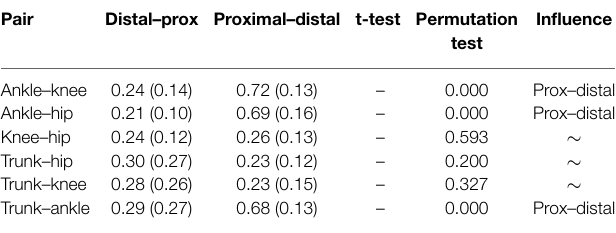
TABLE 1 | Average values (SD) computed from causal influence in the sagittal plane kinematic data during running. Pair Distal–prox Proximal–distal t-test Permutation